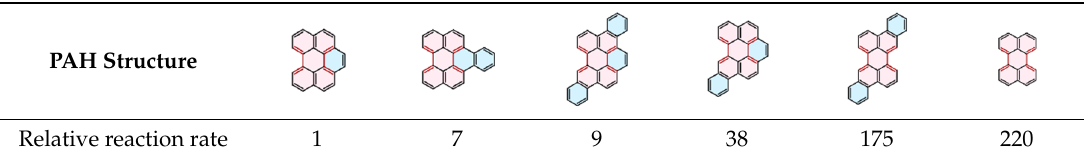
Table 1. Relative reactivity of perylene and their benzo-, naphtho-, and dibenzoderivatives in the DA cycloaddition of phthalic anhydride to the bay region [201].